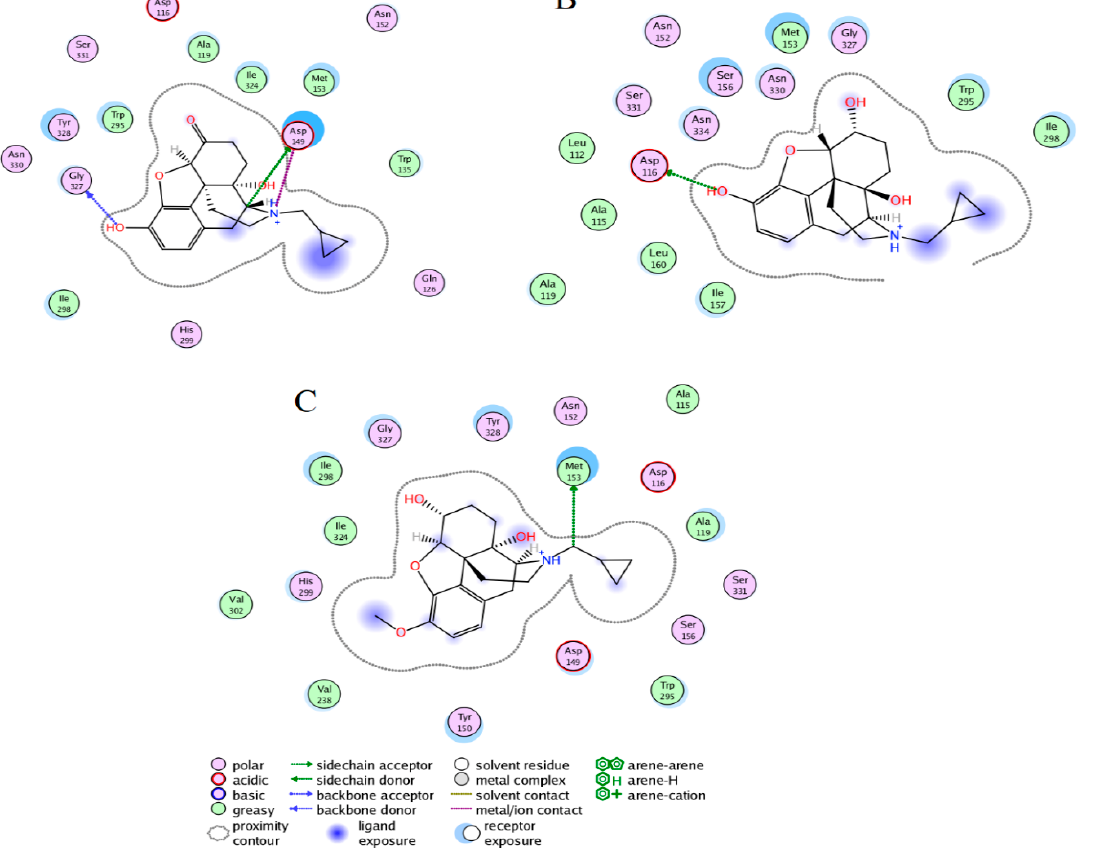
Figure 2. Protein–ligand interactions of naltrexone, NTXOL, or HMNTXOL with hMOR. Interac- tions of naltrexone ( A ), NTXOL ( B ), or HMNTXOL ( C ) with hMOR present in the most populated conformations through MD